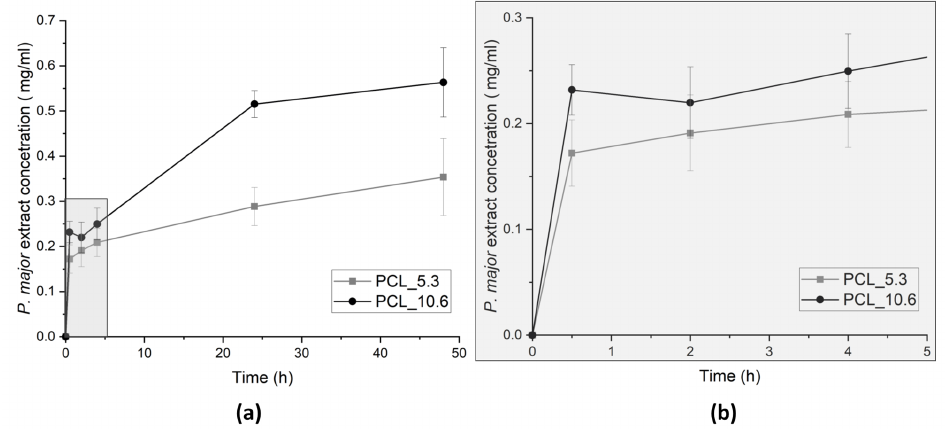
Figure 9. P. major extract release from PCL/ P. major electrospun mats as a function of the immersion time in phosphate buffer solution—PBS (pH 7.4): ( a ) 48 h of assay, and ( b ) zoom of the evolution of the release assay in the fi rst 5 h.